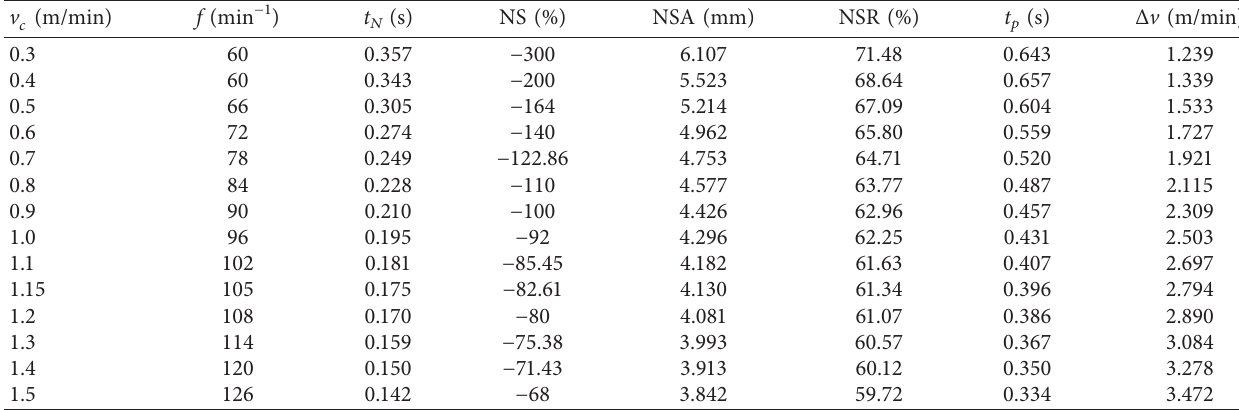
Table 2: Technological parameters of nonsinusoidal